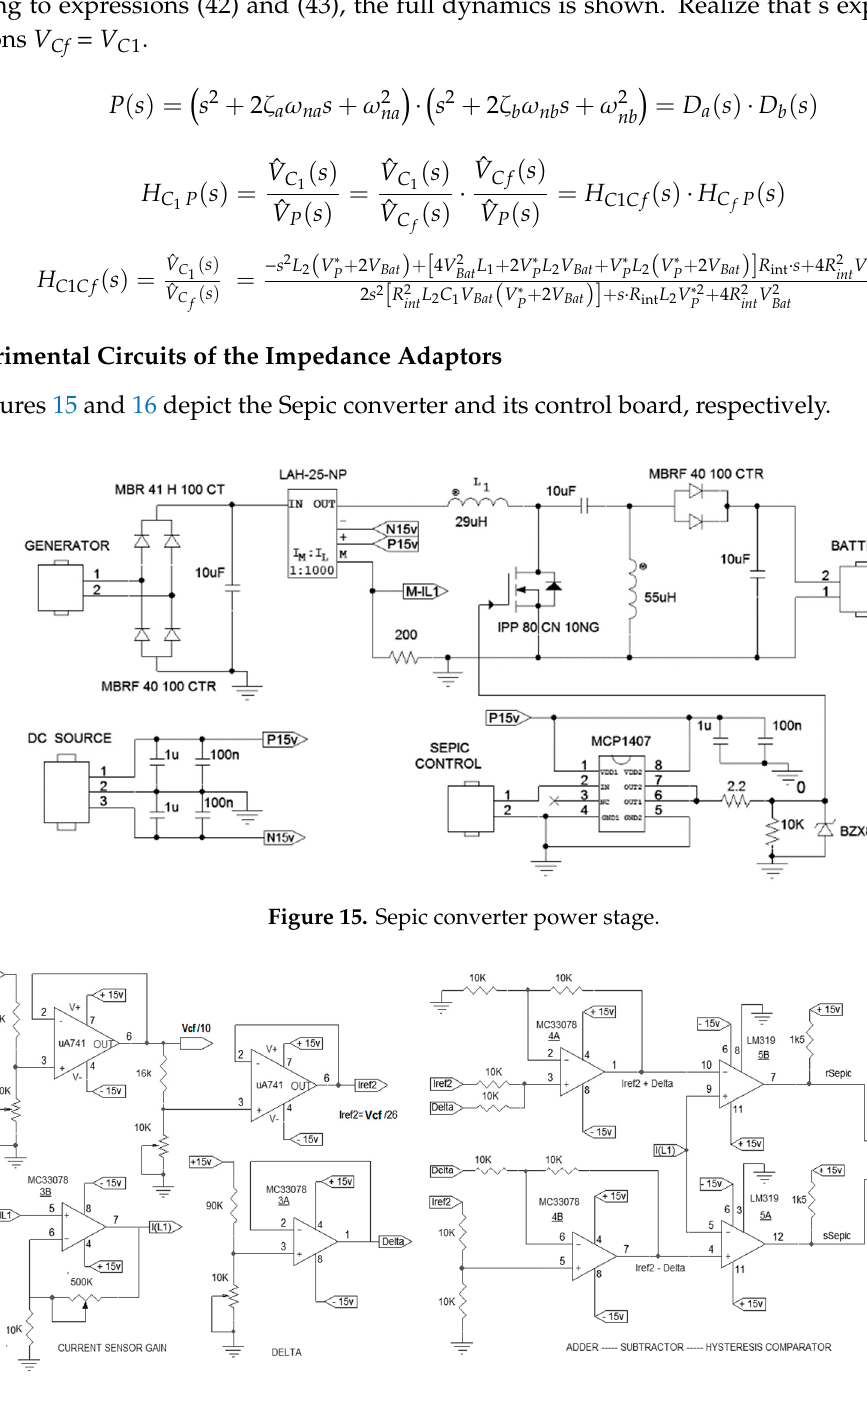
Figure 16. Sepic control board.